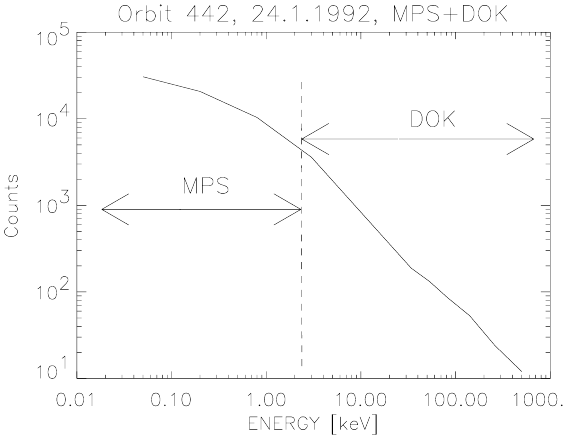
Fig. 2. Energy spectrum of the electron burst as a result from the data of two spectrometers, MPS and